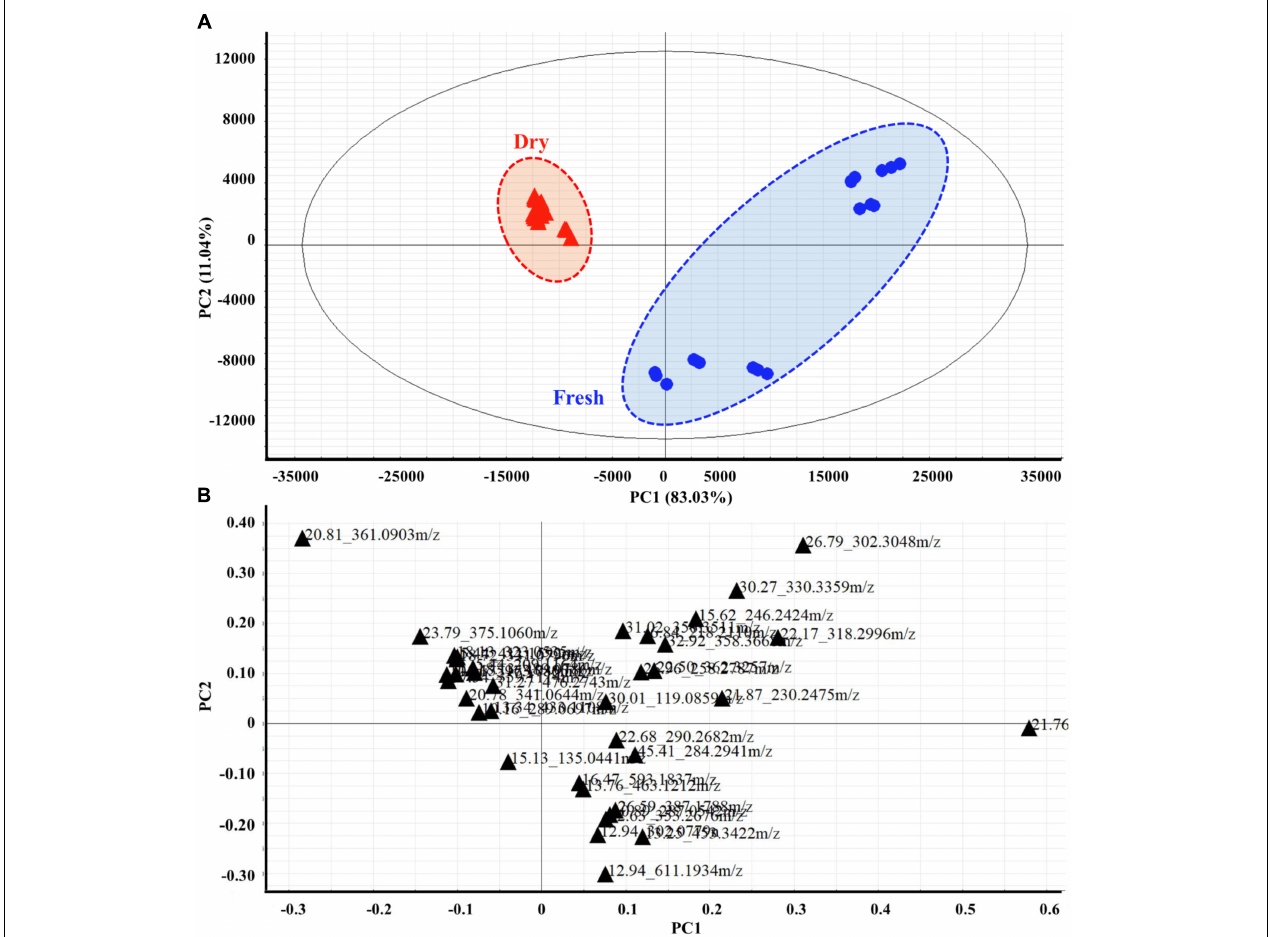
FIGURE 4 | Two-dimensional PCA score plots (A) and loading plots (B) derived from HPLC-MS spectra data sets of fresh and dried leaves, showing that the metabolomes were clearly different between the two groups. Score plots are described by two vectors of principal component 1 PC1 = 83.03% and PC2 = 11.04%. Each metabolite is denoted by its Rt (min) – Mass pair in loading